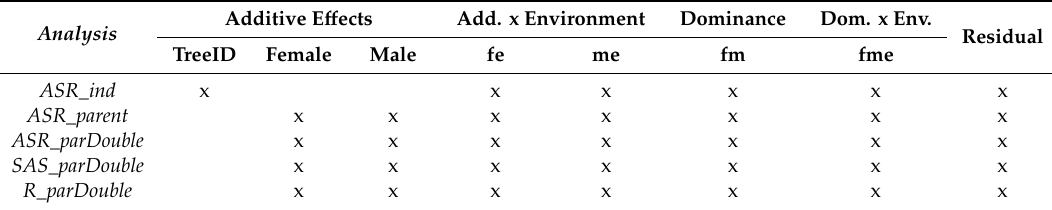
Table 1. Summary of random e ff ects included in the five di ff erent linear mixed